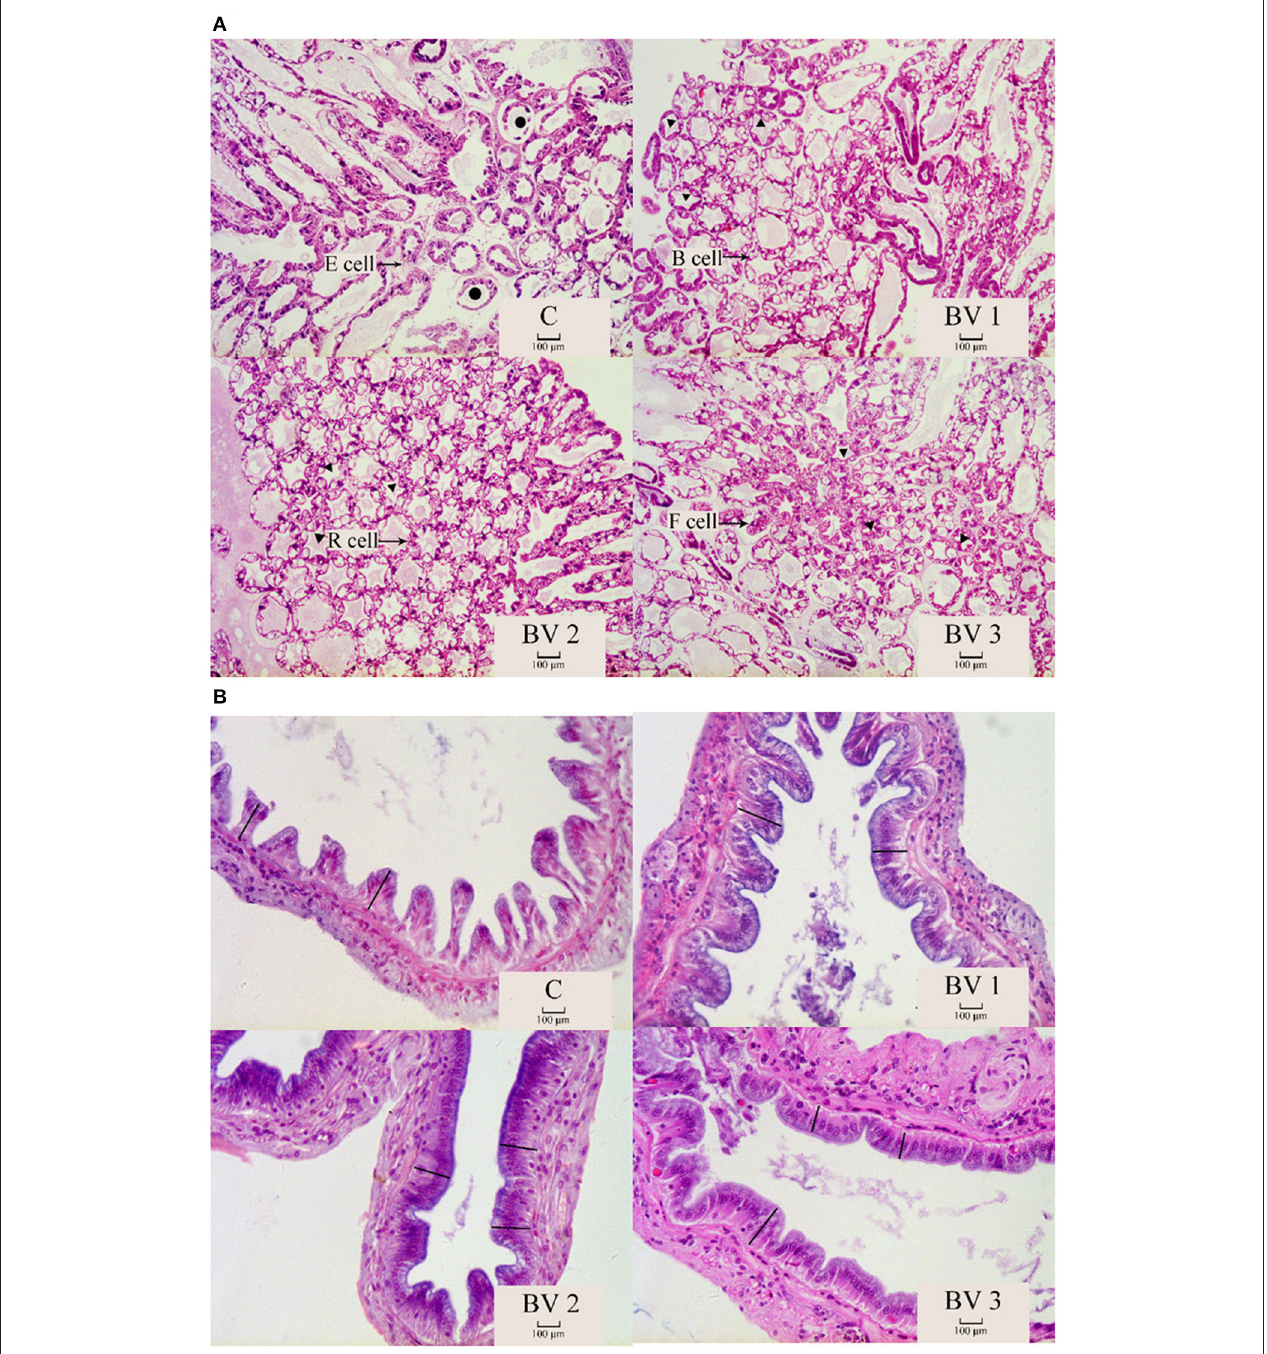
FIGURE 3 | The morphological structure of hepatopancreas (A) and intestine (B) . C, 0 CFU/g; BV1, 10 5 CFU/g group; BV2, 10 7 CFU/g group; BV3, 10 9 CFU/g group. •: liver tubules are round; N : the liver tubules are star-like or polygonal. -: intestinal villus.